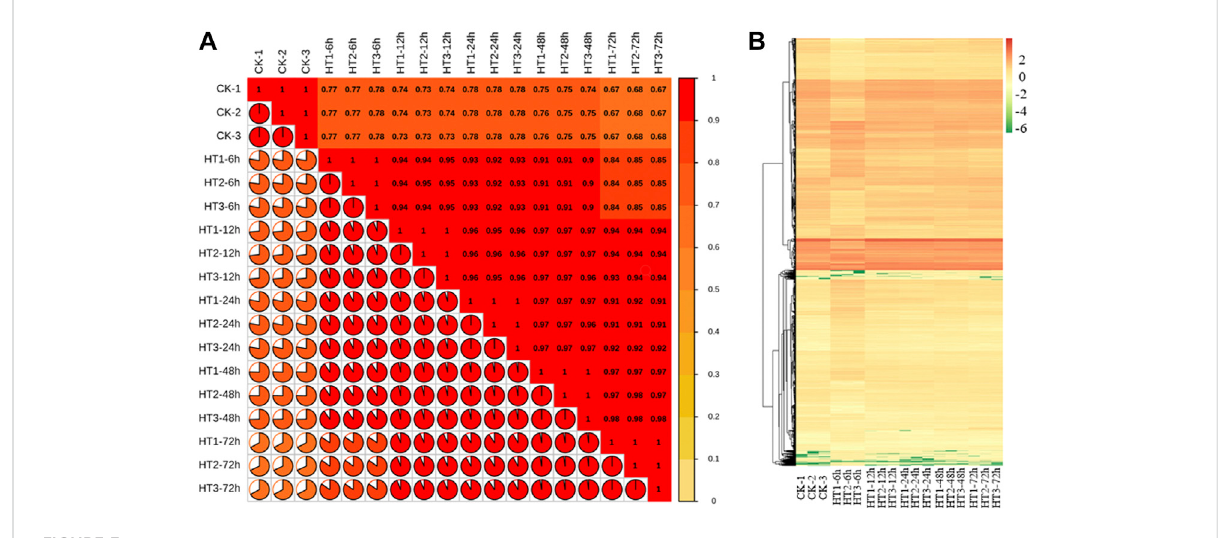
FIGURE 3 Analysis of gene expression in response to high temperature. (A) Heat map of correlation coef fi cient values across samples based on RNAseq FPKM. (B) Clusteranalysis ofDEGsof0(CK), 6,12,24,48, 72 haftertreated withhightemperaturetreatment.CKisthesampleof0 h.HTmeanshigh temperature. DEG means differential expressed